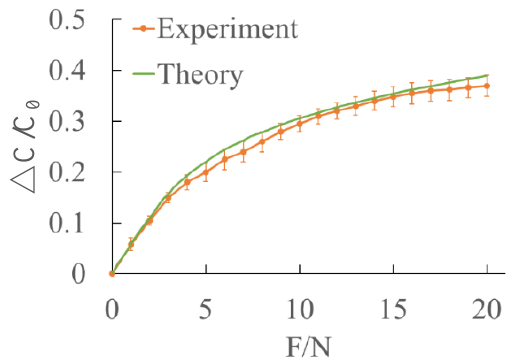
Figure 12. Comparison of experimental data and theoretical data under normal force loading.